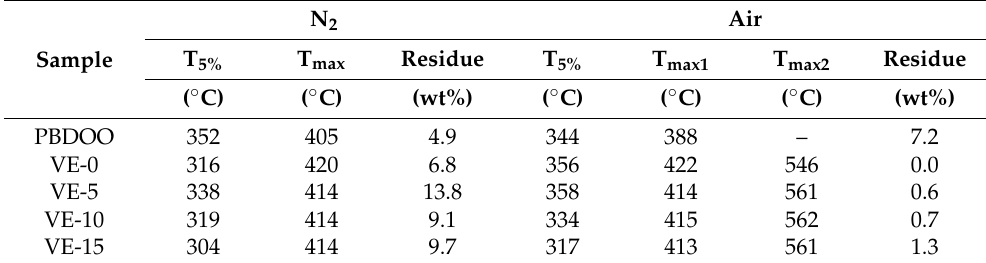
Figure 2. TGA and DTG curves of PBDOO in ( a ) Air and ( b ) N 2 . Table 2. TGA and DTG data of PBDOO and the VE composites.